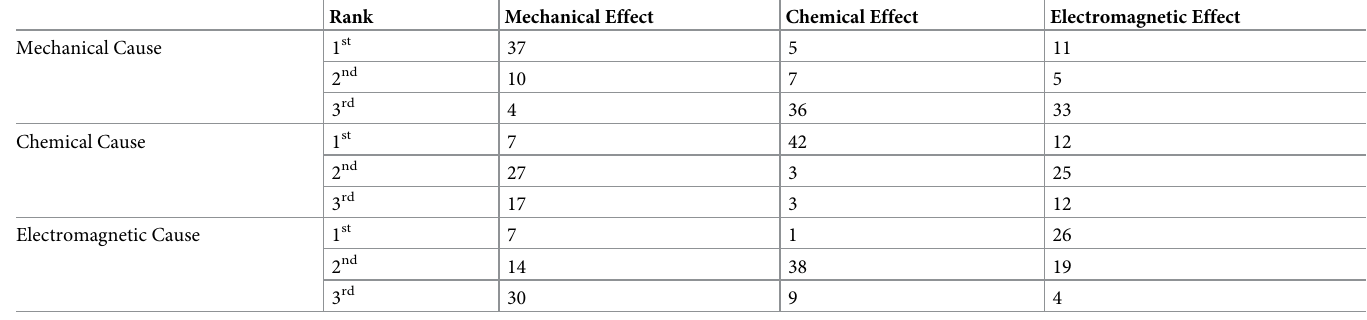
Table 3. A frequency listing of all ranking